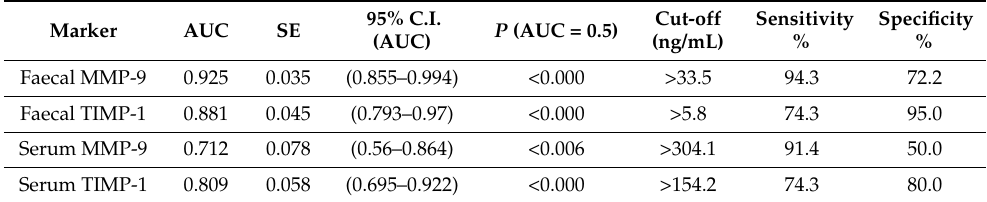
Table 3. Diagnostic performance of MMP-9 and TIMP-1 in differentiating UC and